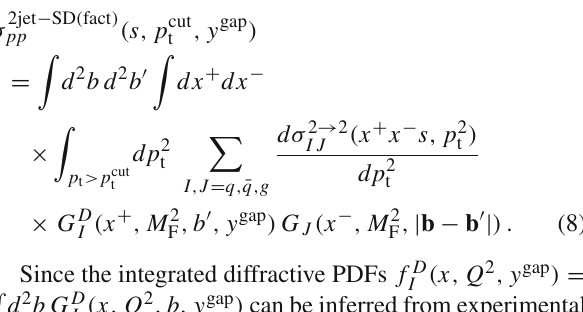
Fig. 5 Schematic view for central hard diffraction; parton J is emitted from a cut Pomeron at the central rapidity. Eikonal absorption due to constituent parton rescatterings is shown symbolically by the vertical ellipse marked “ S 2 ”; noneikonal absorptive corrections due to rescat- eik terings of intermediate partons mediating the diffractive scattering are indicated by inclined ellipses. The cut plane is shown by the vertical dotted-dashed line; the rapidity gaps are also indicated The analog of Eq. (5) for single (here, projectile)